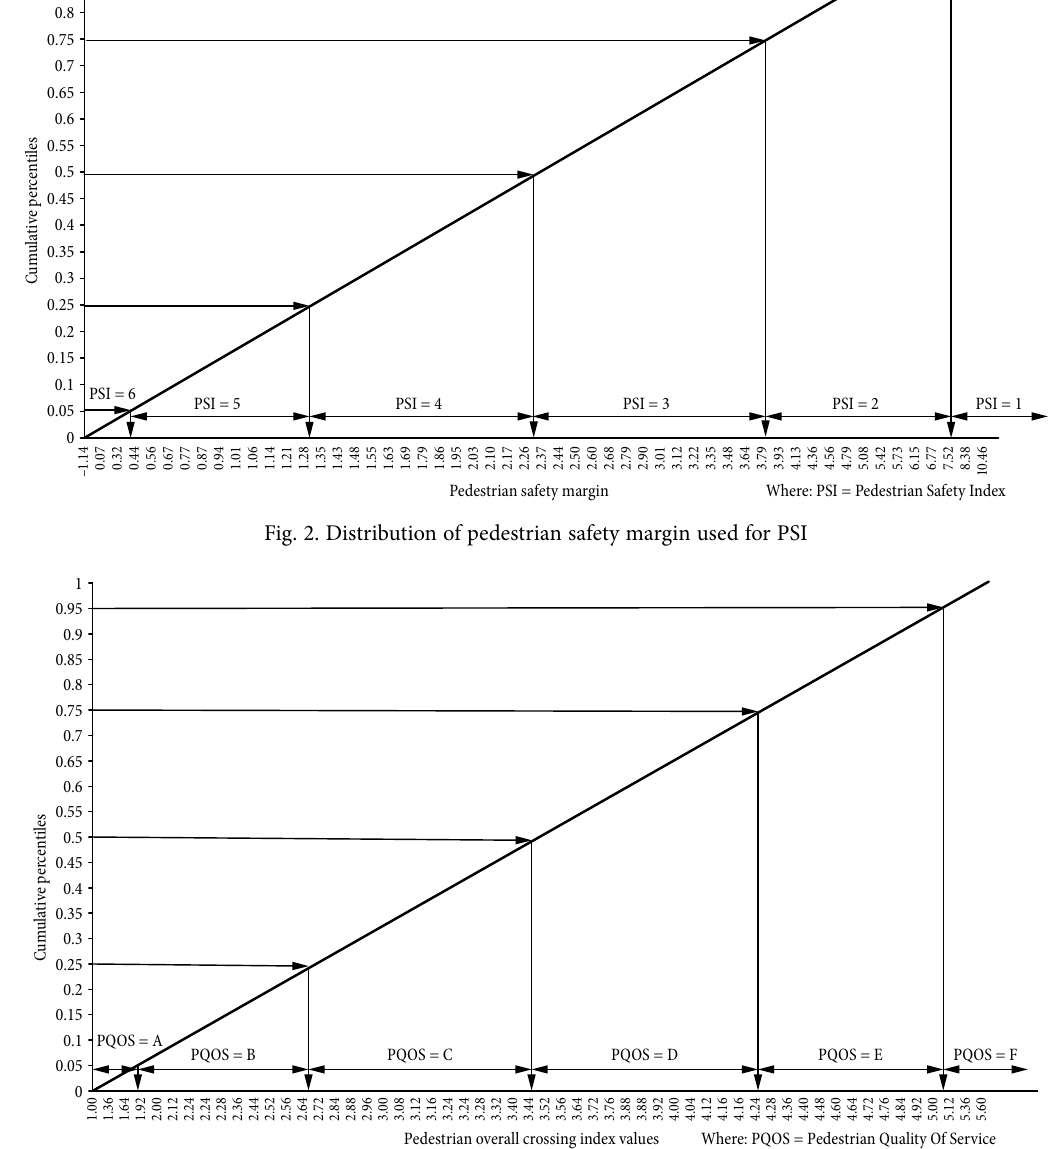
Fig. 3. Distribution of PCI used for pedestrian